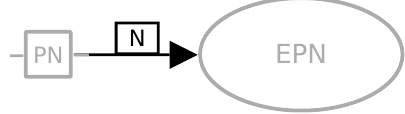
Figure 2.39: The Process Description glyph for production .